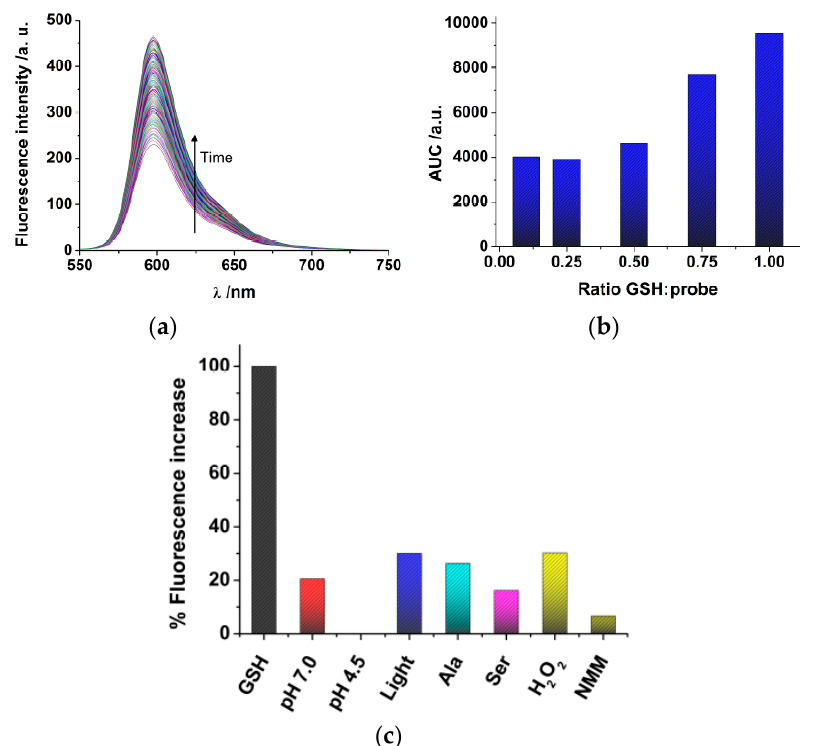
Figure 1. ( a ) Temporal evolution of the fluorescence emission spectra ( λ ex = 530 nm) of DNBS-2Me-4OMe-TM (6 × 10 − 7 M) in the presence of a stoichiometric amount of glutathione (GSH). ( b ) Area under the curve (AUC) of the response of DNBS-2Me-4OMe-TM (6 × 10 − 7 M) with different concentrations of GSH. ( c ) Stability and selectivity study of the fluorogenic reaction of DNBS-2Me-4OMe-TM (6 × 10 − 7 M).